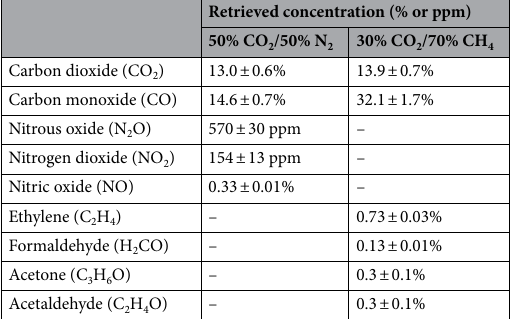
Table 1. Retrieved concentrations of electric discharge products.